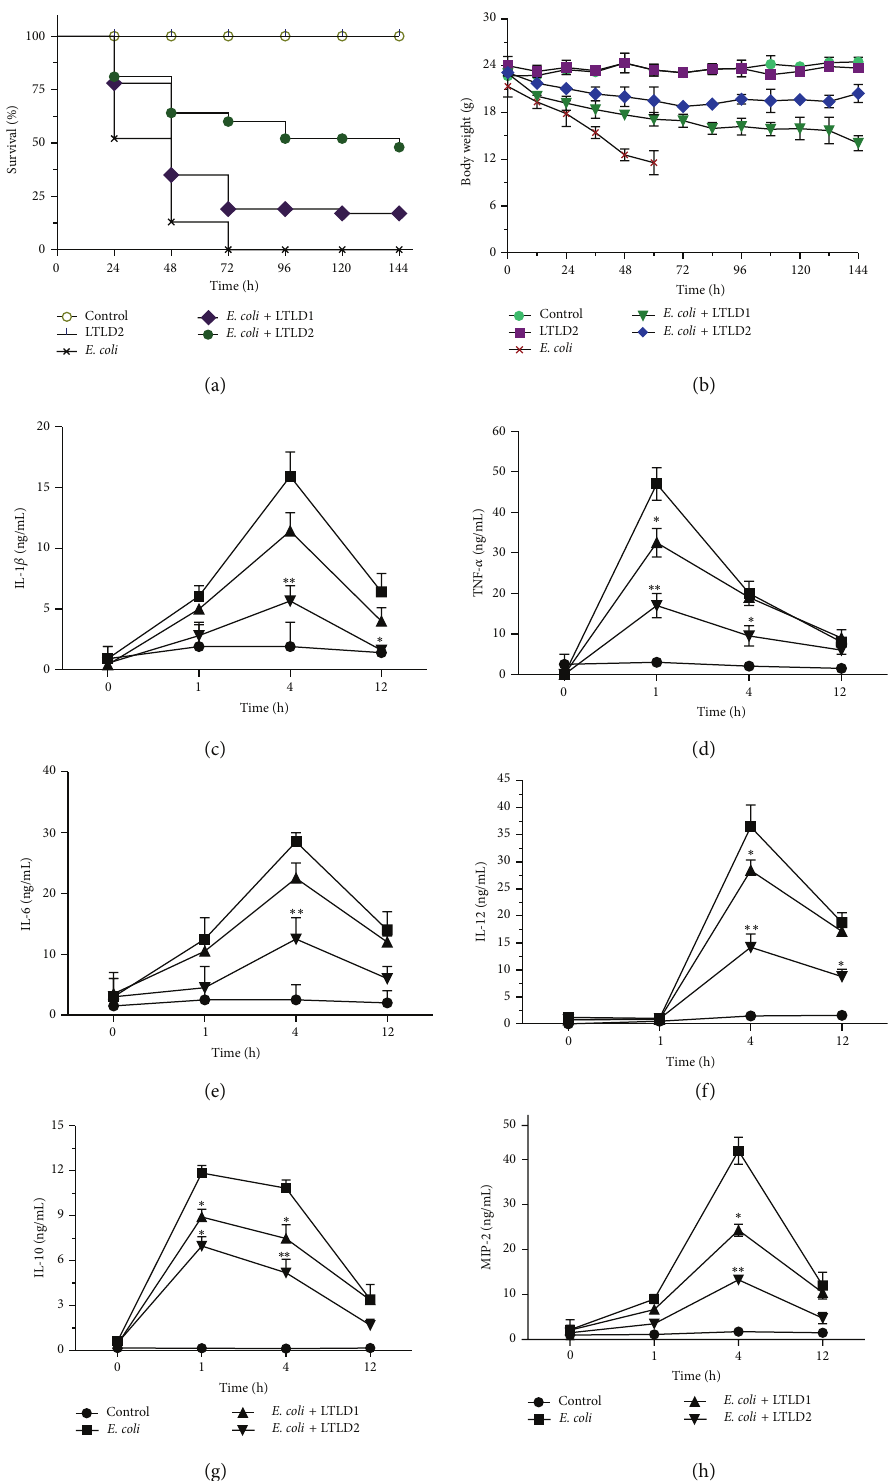
Figure 4: Effect of LTL on (a) survival and (b) body weight of mice ( 𝑛 = 10 ) treated with heat-killed E. coli O18:K1, 10 4 CFU in 200 𝜇 L of sterile isotonic saline. Levels of cytokines IL-1 𝛽 (c), TNF- 𝛼 (d), IL-6 (e), IL-12 (f), IL-10 (g), and MIP-2 (h) were measured by ELISA at 1, 4, and 12h upon treatment with LTL at doses LTLD1 (25 mg/kg) and LTLD2 (50 mg/kg), after challenging with heat-killed E. coli . The data are reported as the mean ± SEM of triplicate experiments. ( ∗ 𝑃 < 0.05 , ∗∗ 𝑃 < 0.01